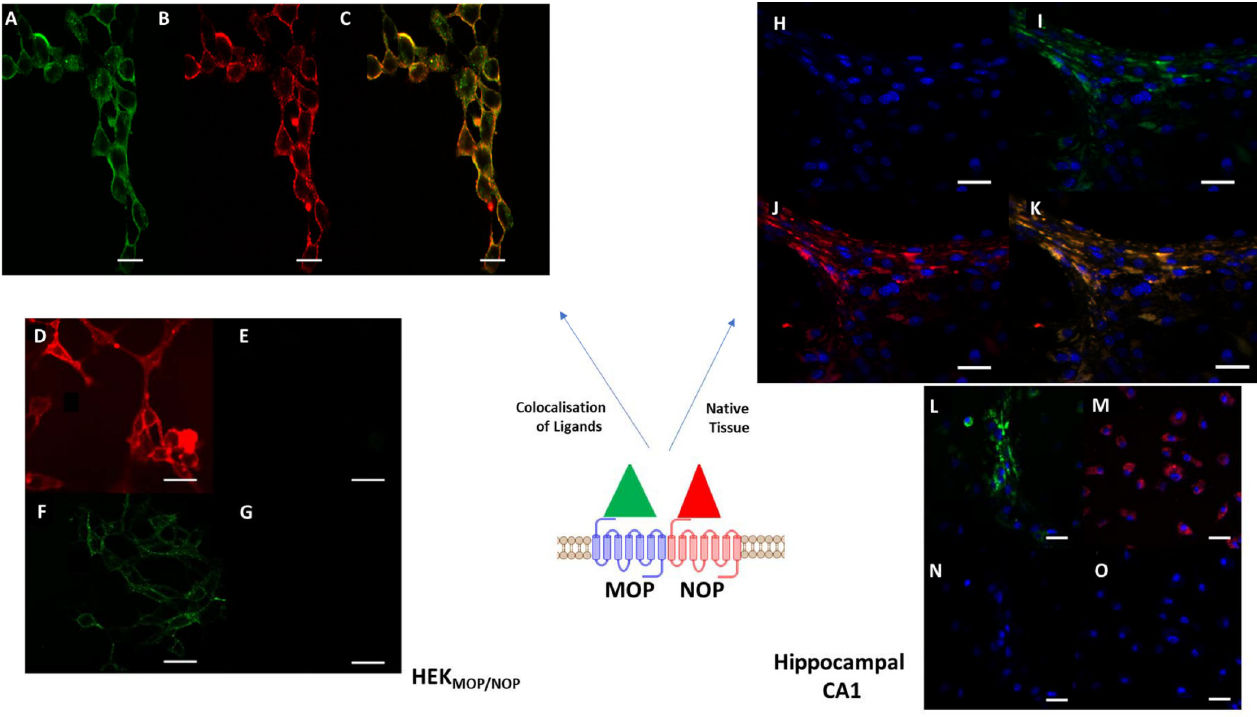
Fig 6. 100nM of Derm ATTO488 (A) and 100nM N/OFQ ATTO594 (B) were co-incubated in HEK MOP/NOP cells at 4˚C, with both ligands binding to the cell surface. Image (C) demonstrates significant colocalisation (Pearson coefficient = 0.91). 100nM of Derm ATTO488 and 100nM of N/OFQ ATTO594 were added to HEK MOP/NOP cells preincubated with 10 μ M naloxone and demonstrated binding of N/OFQ ATTO594 (D) but not Derm ATTO594 (E). 100nM of Derm ATTO488 and 100nM of N/OFQ ATTO594 were added to HEK MOP/NOP cells preincubated with 10 μ M SB-612111 and demonstrated binding of Derm ATTO488 (F) but not N/ OFQ ATTO594 (G). Mouse CA1 hippocampal cells were seeded onto 25mm glass coverslips, allowed to initiate process extension. Cells were treated with Ab- Delivirin ™ coated NeuN-alexaflour 405 antibodies (Blue stained nucleus). Mouse hippocampal CA1 cells (H) were co-treated with 100nM each of Derm ATTO488 (I) and N/OFQ ATTO594 (J). The composite image (K) demonstrates significant co-localisation (Pearson coefficient = 0.83). In order to determine selectivity in mouse hippocampal CA1 tissue, a series of controls were undertaken in the presence of MOP (CTOP) and NOP (SB-612111) antagonists. In the presence of 10 μ M SB-612111, 100nM Derm ATTO488 (L) bound to CA1 hippocampal cells, while the binding of N/OFQ ATTO594 was inhibited (N). 100nM Derm ATTO488 failed to bind to CA1 hippocampal cells after pretreatment with 10 μ M CTOP (O), however 100nM N/OFQ ATTO594 (M) retained binding affinity. All data are representative of 5 separate experiments. Scale bar (white) represents 20 μ